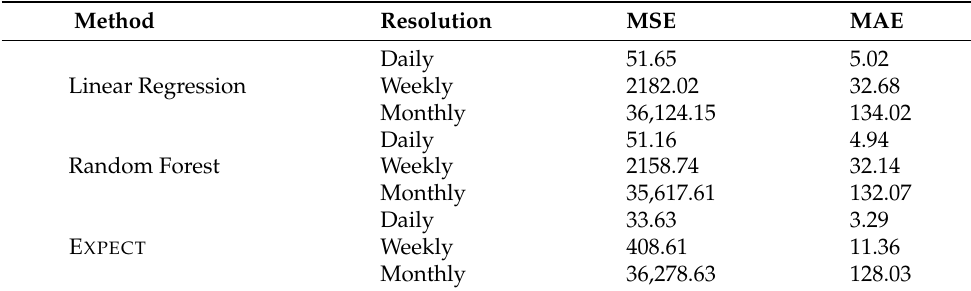
Table 7. Performance evaluation with SDC and CDC.